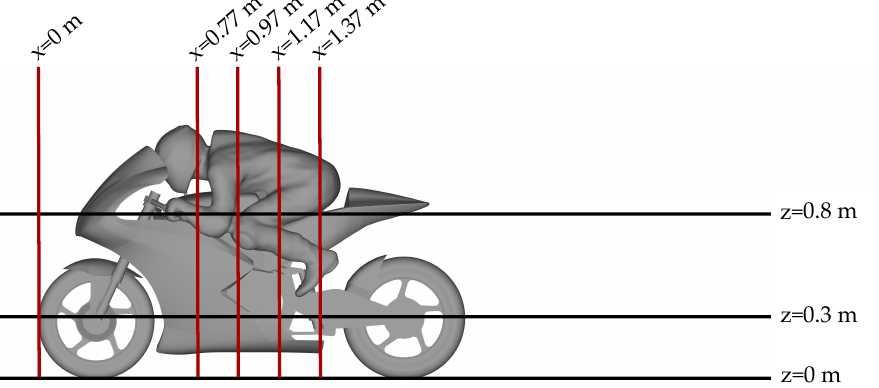
Figure 14. Location of cross sections of the computational domain allowing accurate analysis of the development of vortex